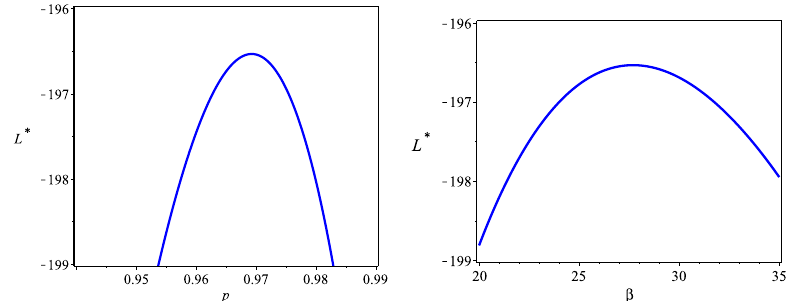
Figure 11. The profile L functions of the DEBuH parameters for data set